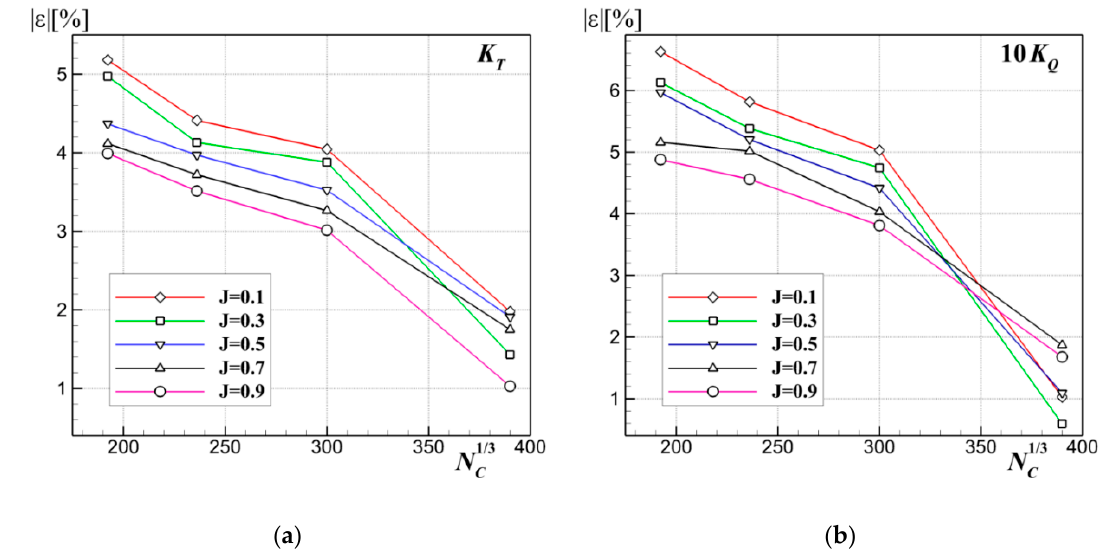
Figure 5. Computational error versus the cubic root of the cell number ( N C ). ( a ): K T ; ( b ):10 K Q .